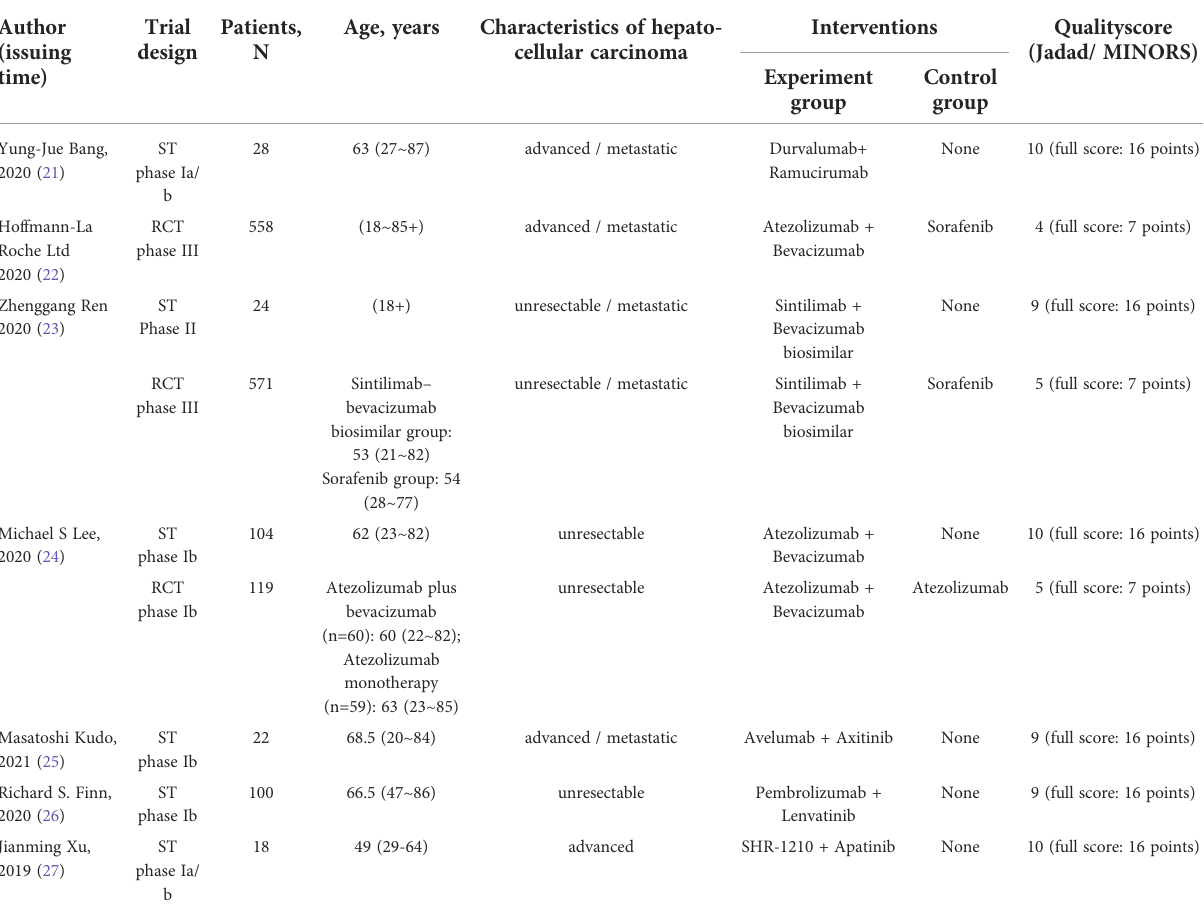
TABLE 1 Basic characteristics of studies included in this